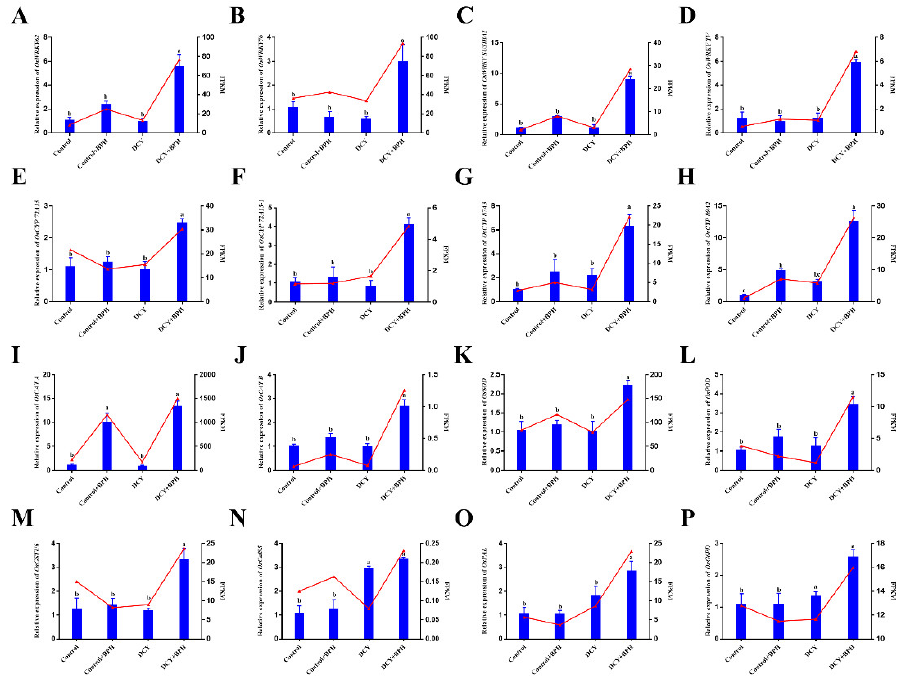
Figure 8. qRT-PCR verification of DEGs. The relative expression level of sixteen genes was determined by qRT-PCR and compared with the transcriptome results. ( A ). OsWRKY62, WRKY transcription factor WRKY62 (LOC4347070). ( B ). OsWRKY76, WRKY transcription factor WRKY76